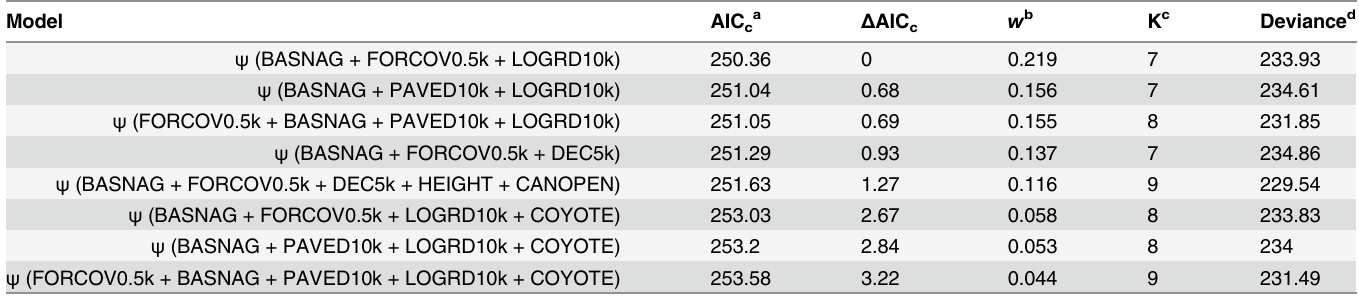
Table 1. U . americanus habitat models. Ranking of best U . americanus multi-scale habitat models in the 90% confidence set. We fit encounter history data from surveys at 54 sites in Adirondack Mountains, New York, USA to each candidate model set. See S1 Table for habitat variable descriptions. Model